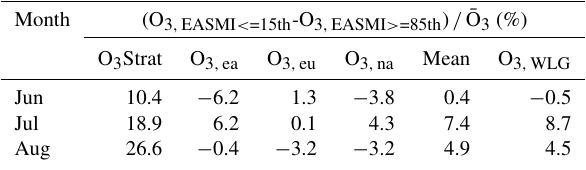
Figure 17. Comparison between the fifth IMF and the 1-year run- ning average SSN during